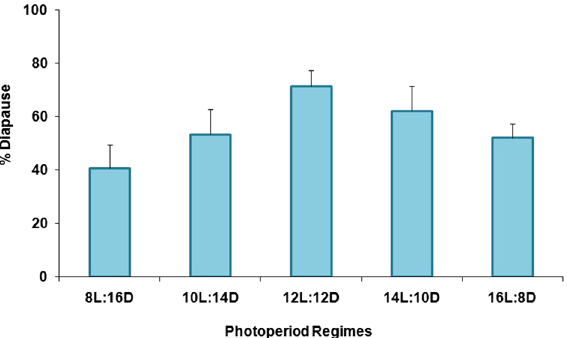
Figure 1. Percentage (% ± SE) of diapausing larvae of P. interpunctella at different photoperiods, at 17 °C.